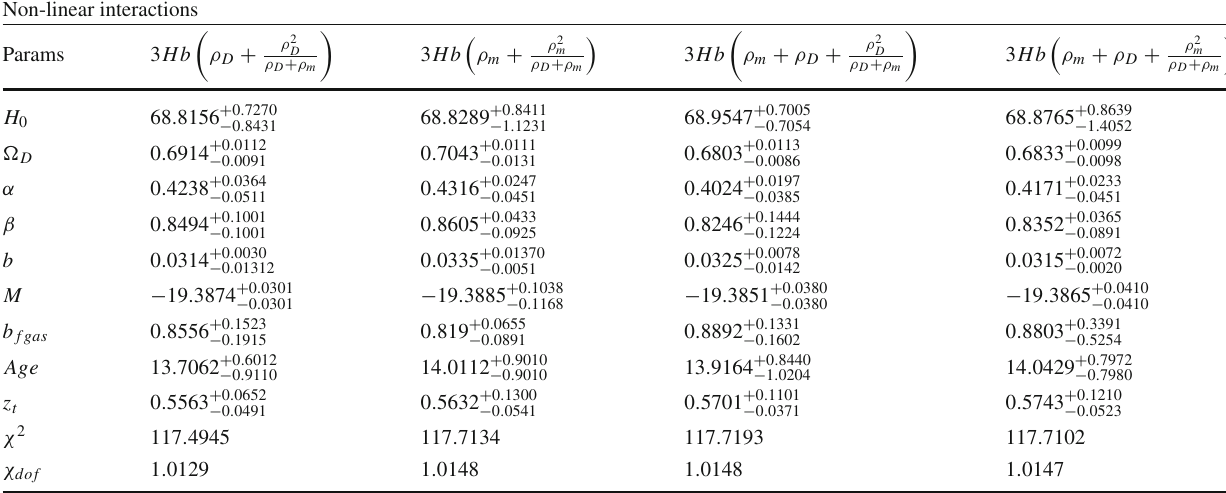
Table 5 The fitted values of cosmological parameters for the extended holographic Ricci dark energy model (Eqs. (21) and (22)) using linear and non-linear interactions listed in Table 1. The Pantheon supernova galaxy clusters (GC) data has been used (see Appendix A)